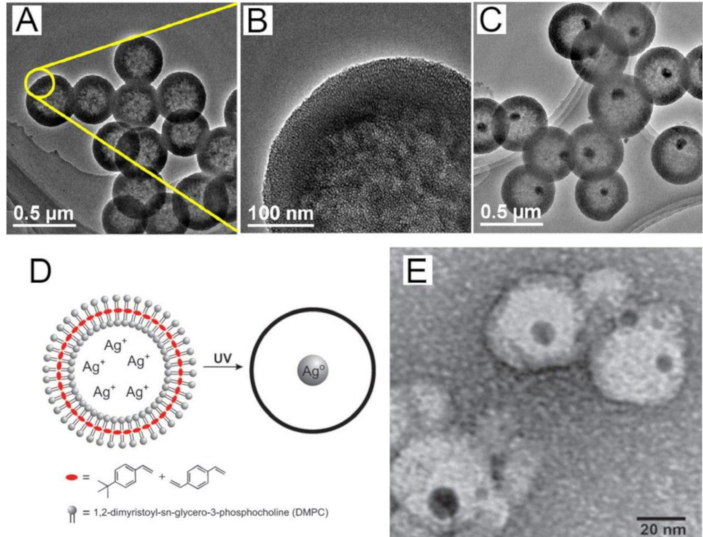
Figure 3. Self-templating syntheses for yolk–shell nanostructures. ( A – C ) TEM images of